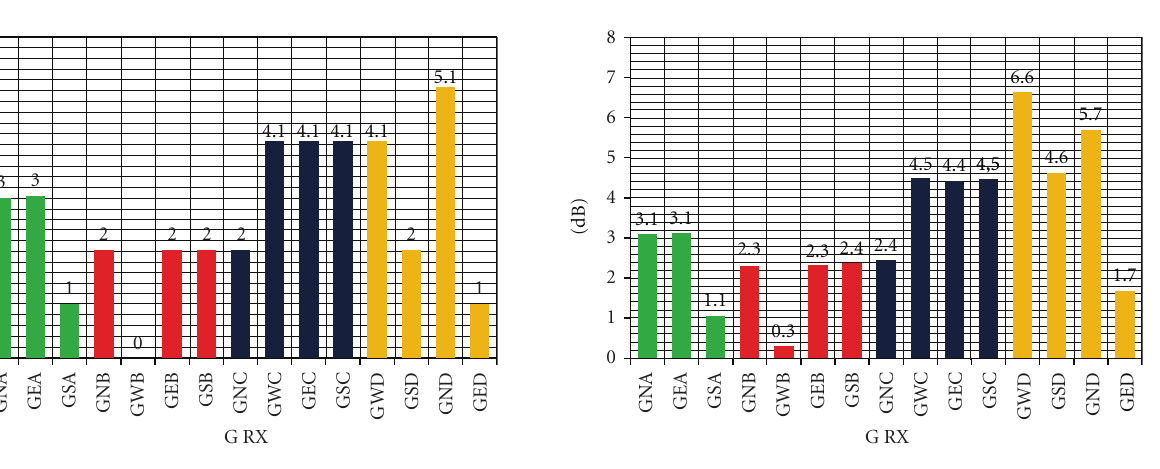
Figure 9: Insertion-loss comparison for the 4 × 4 square root topology of Figure 8, by considering injection from G4 and without accounting for the inter-express lanes loss-contributions. Every intersection is optimized with standard elliptical tapers.